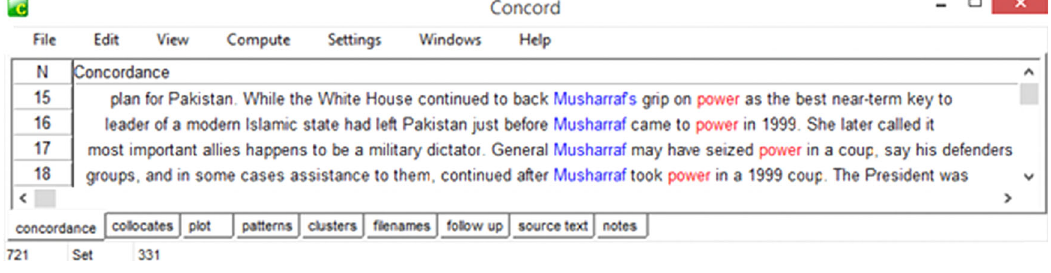
Fig. 10 Concordance extract. Concordance extract Power-Musharraf*